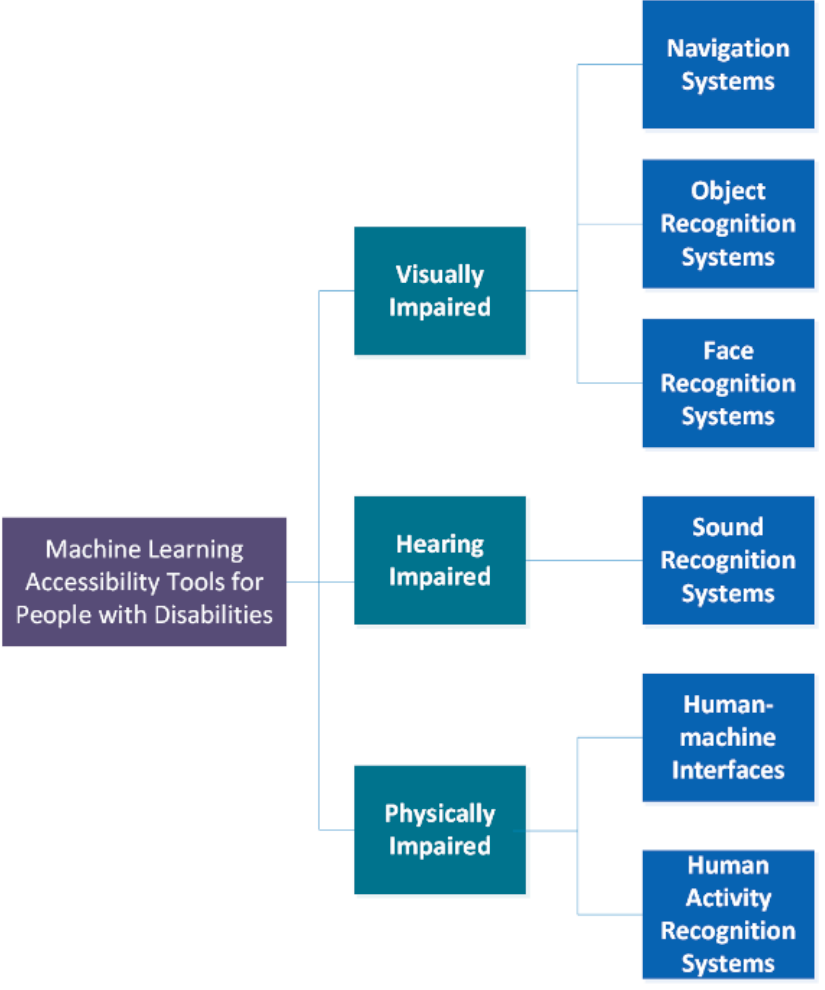
Figure 2. Proposed taxonomy of machine learning accessibility tools.